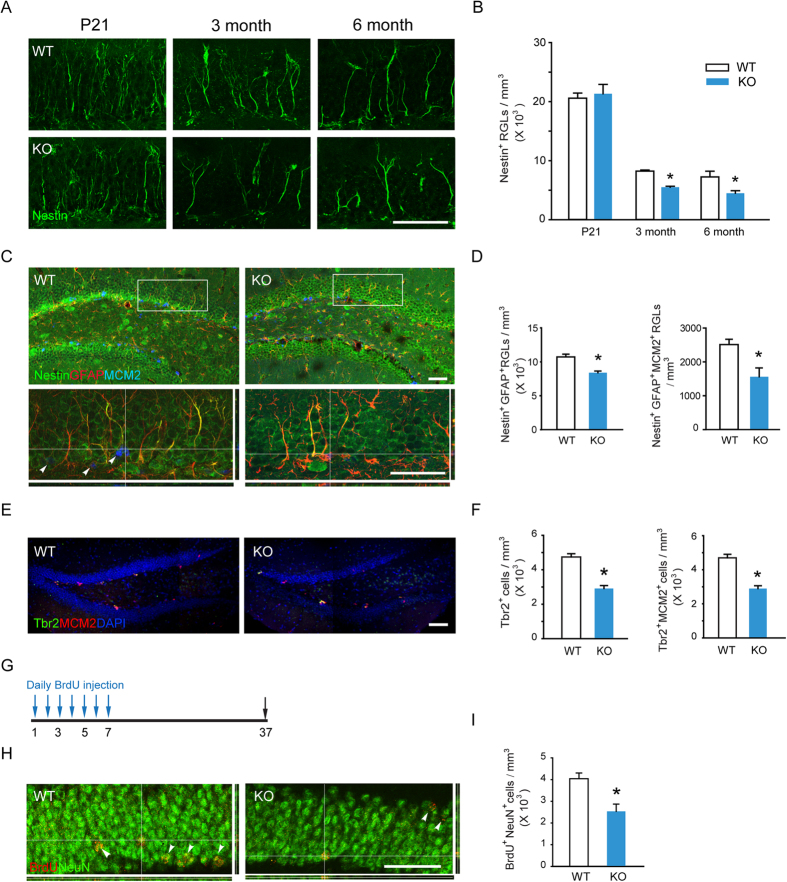
Ablation of β-arr1 Reduces NSC Activation and Neuronal Production in Adult DG.(A,B) Sample projected confocal images and stereological quantification of Nestin+ RGLs in DG of P21, 3 and 6 month-old mice. The number of RGLs was normalized to the GCL volume; two-way ANOVA, post hoc Tukey test. (C,D) Sample projected confocal images and stereological quantification of Nestin+ GFAP+ RGLs and Nestin+ GFAP+ MCM2+ RGLs in the DG of WT and KO mice. Orthogonal images ((C), bottom) are shown to confirm colocalization. (E,F) Confocal images and quantification of Tbr2+ IPCs and Tbr2+ MCM2+ IPCs in SGZ of WT and KO mice. (G) Schematic of experimental schedule. WT and β-arr1 KO mice were injected with BrdU (i.p., 100 mg/kg) for 7 days, and sacrificed 30 days after the last BrdU injection. (H,I) Sample projected confocal images and stereological quantification of BrdU+ NeuN+ cells in DG. High magnification orthogonal images show the colocalization of BrdU and NeuN. Data are mean ± s.e.m.; n = 5–6 per genotype; *p < 0.05 versus WT, t-test; Scale bar, 50 μm.